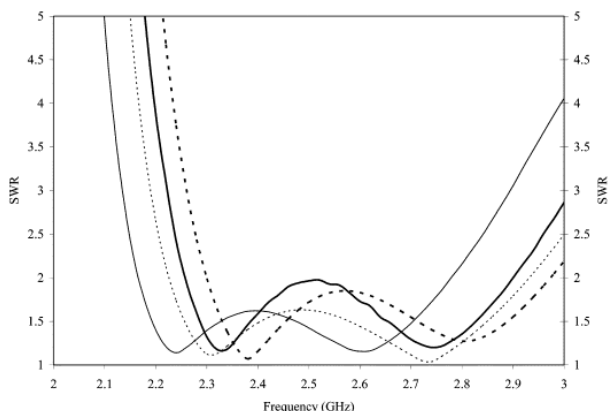
FIGURE 12. VSWR performance of a linearly-polarized half E-shaped patch antenna and its corresponding E-shaped patch where W f = 2 W . — half E-patch (measured), - - - half E-patch (simulated), — full E-patch (measured), - - - full E-patch (simulated). Adapted from [22].